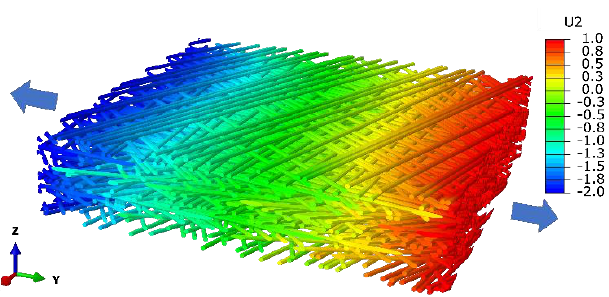
Figure 5. Finite element simulation of uniaxial tension on the microfibril network with displacement field (U2, nm) along the tension direction (Y axis). The legend illustrates values of different colors.